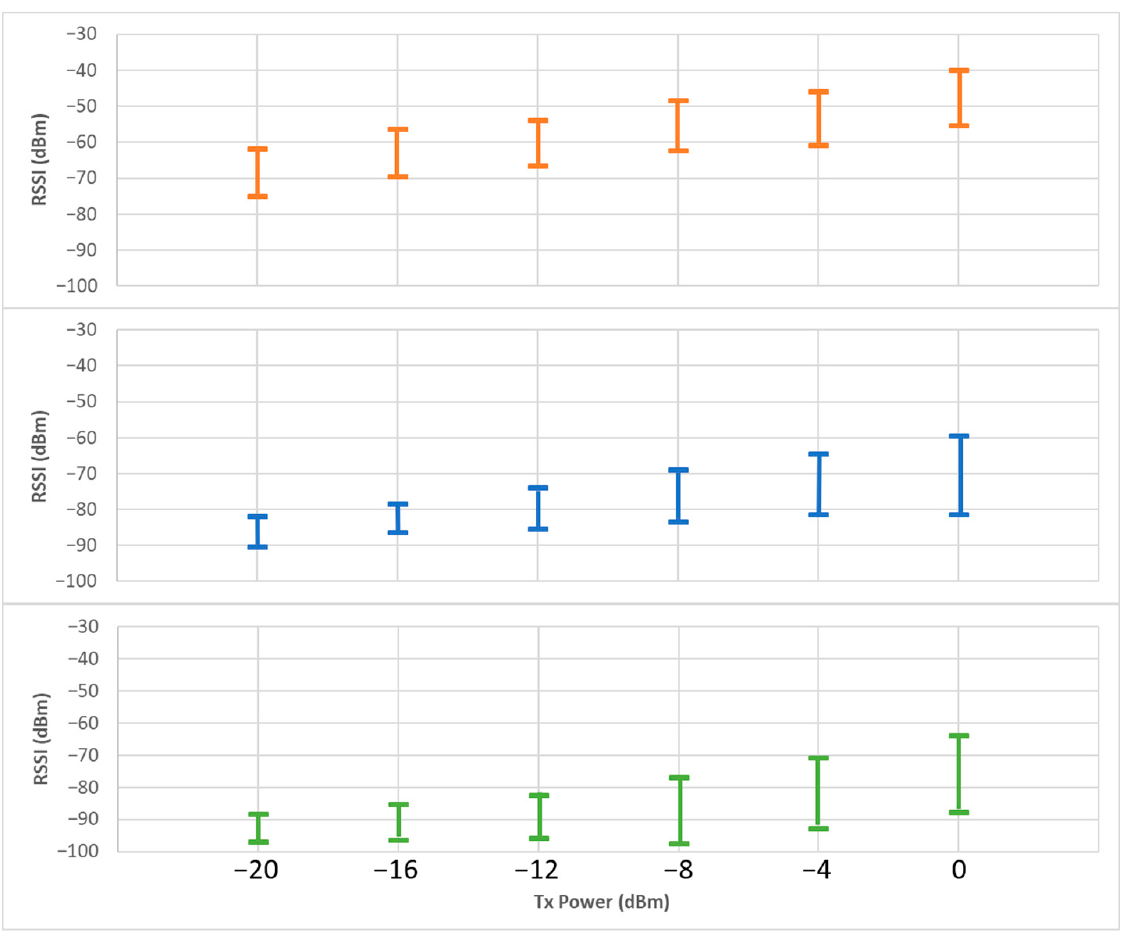
Figure 16. Effect of the transmit power on the height of the periodic RSSI peak shape for Subject A with the sender node on the wrist location. Average maximum and average minimum values for each power level: ( top ) 433 MHz, ( middle ) 868 MHz, ( bottom ) 2.4 GHz.